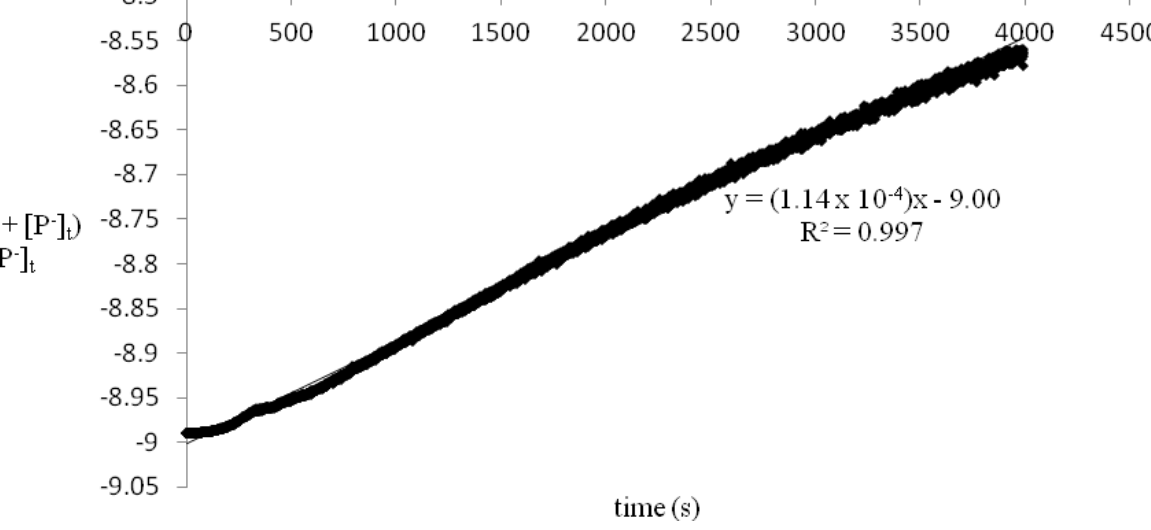
+ [P − ] ) − ln[P − ] vs. time for reaction of 2.40 × 10 − 5 M benzylamine o t t